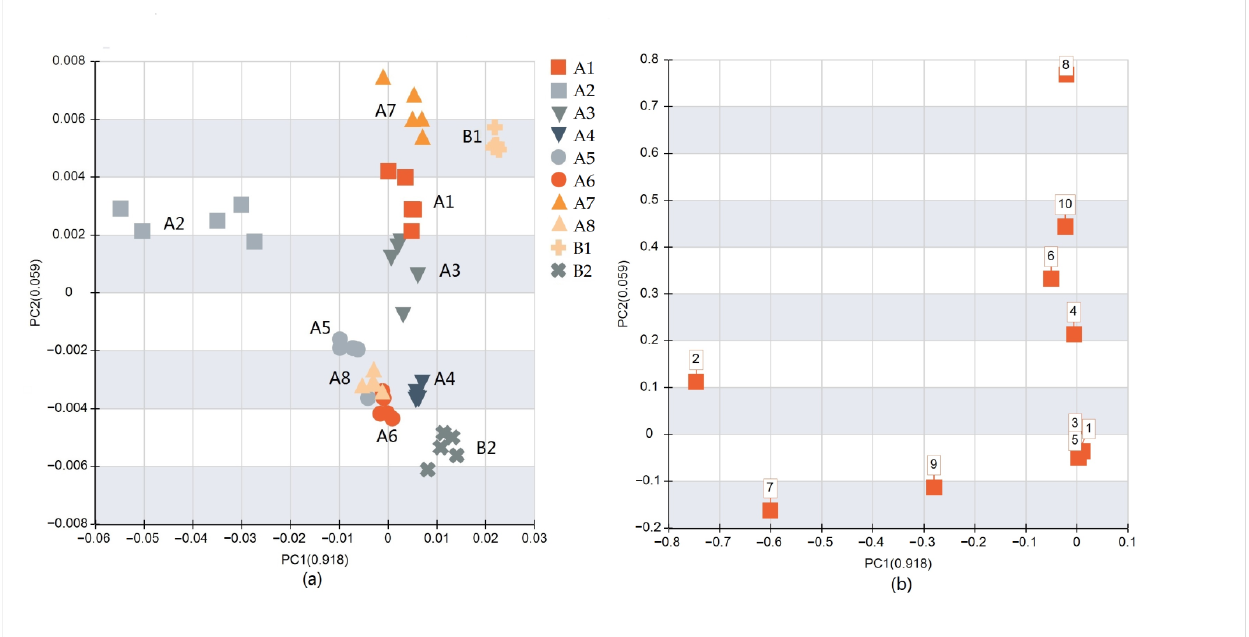
Figure 3. ( a ) Separation of the 10 groups in PCA space based on the data of E-nose; ( b ) distribution of 10 sensor responses in the 10 groups (numbers correspond to those in Table 1).